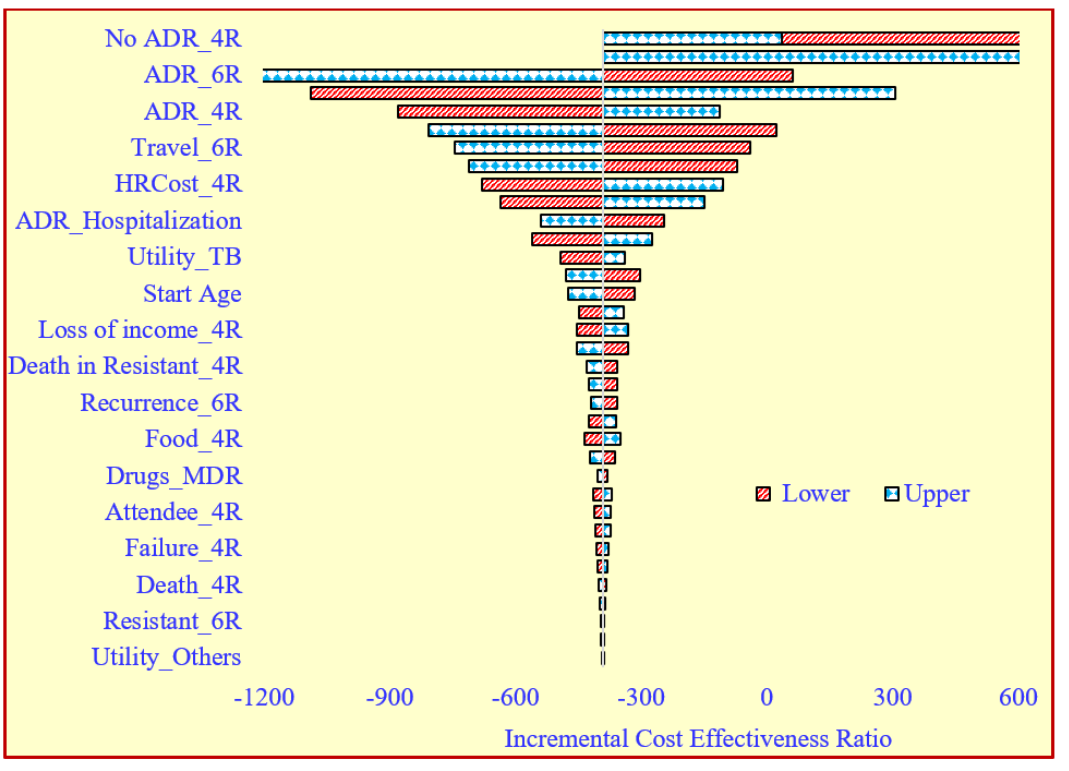
Figure 2. Tornado plot illustrating the one-way sensitivity analysis to see the impact of variation in input parameters on ICER. 4R—Four-month regimen, 6R—Six-month regimen, HR—Human resource, ADR—Adverse Drug Reaction, MDR—Multidrug-resistant.